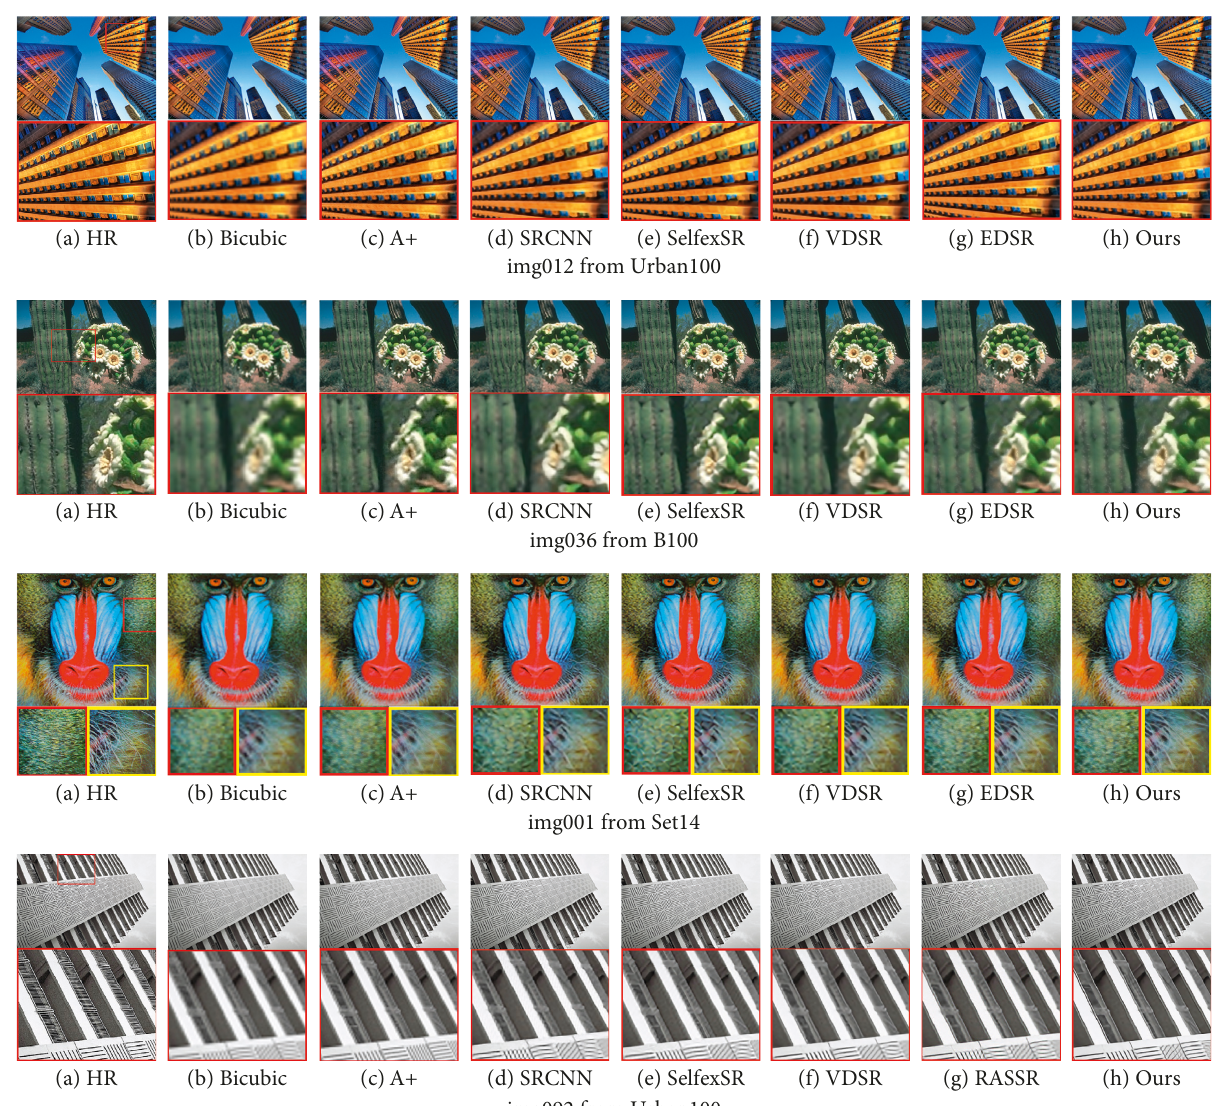
Figure 9: Super-resolution results for scale factor 4. Below each image is a partial enlargement.